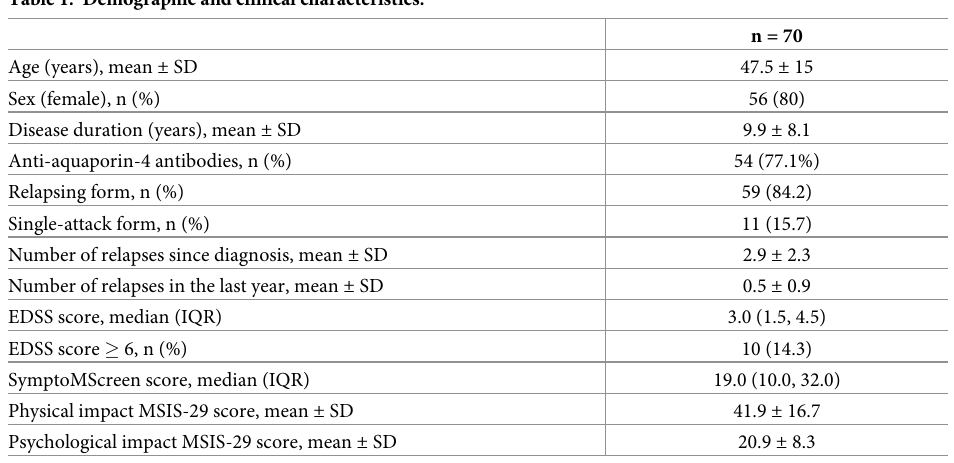
Table 1. Demographic and clinical characteristics.